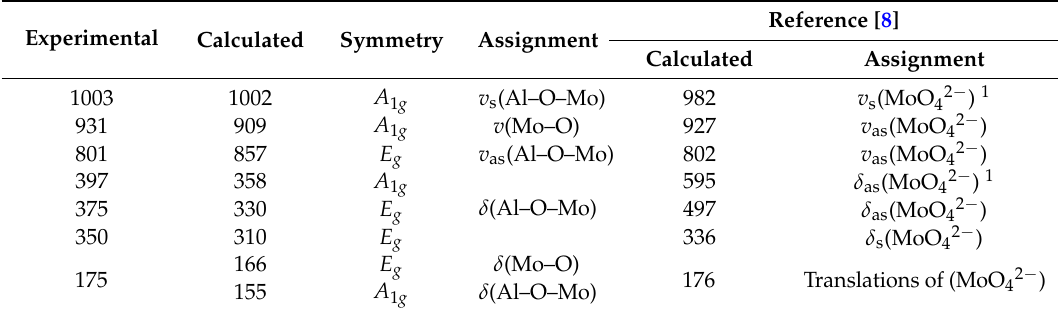
Table 3. Experimental and calculated wavenumbers (cm − 1 ) by CASTEP of the Raman vibrational modes of KAl(MoO 4 ) 2 prepared under slow cooling condition, together with proposed assignments. Experimental